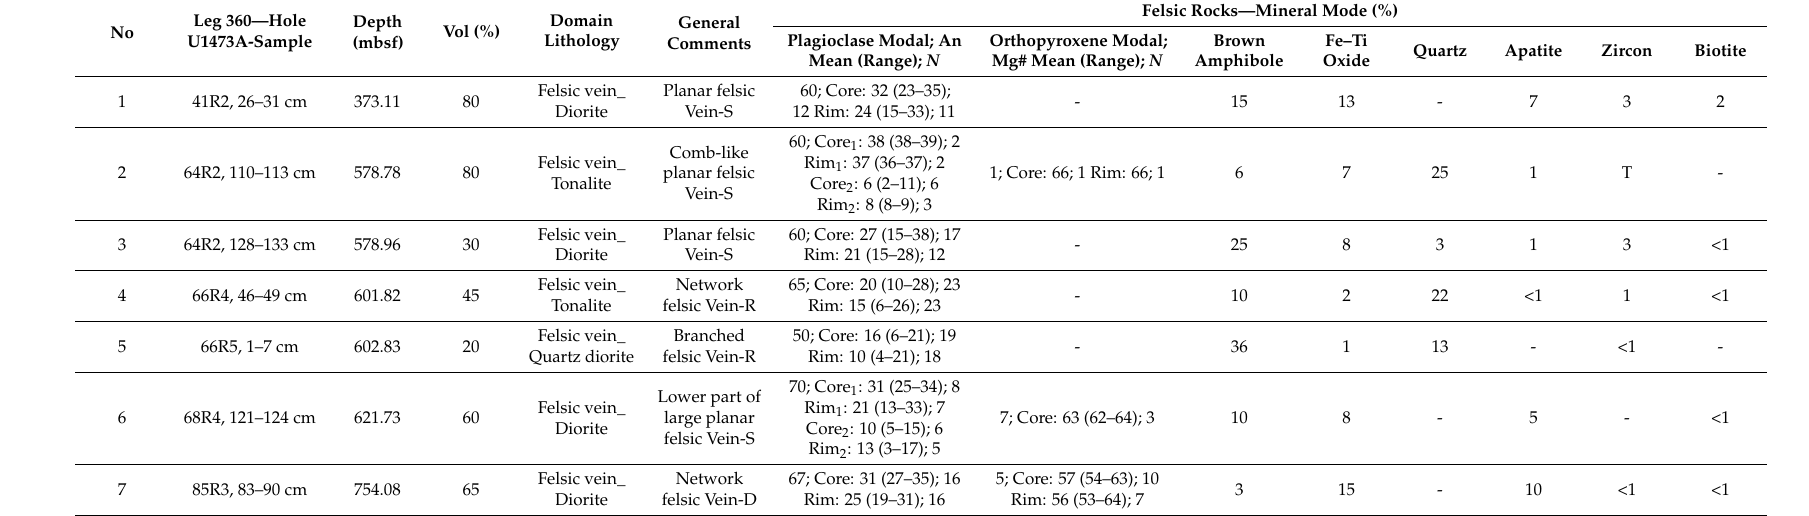
Table 2. Detailed characteristics of studied felsic vein samples—Hole